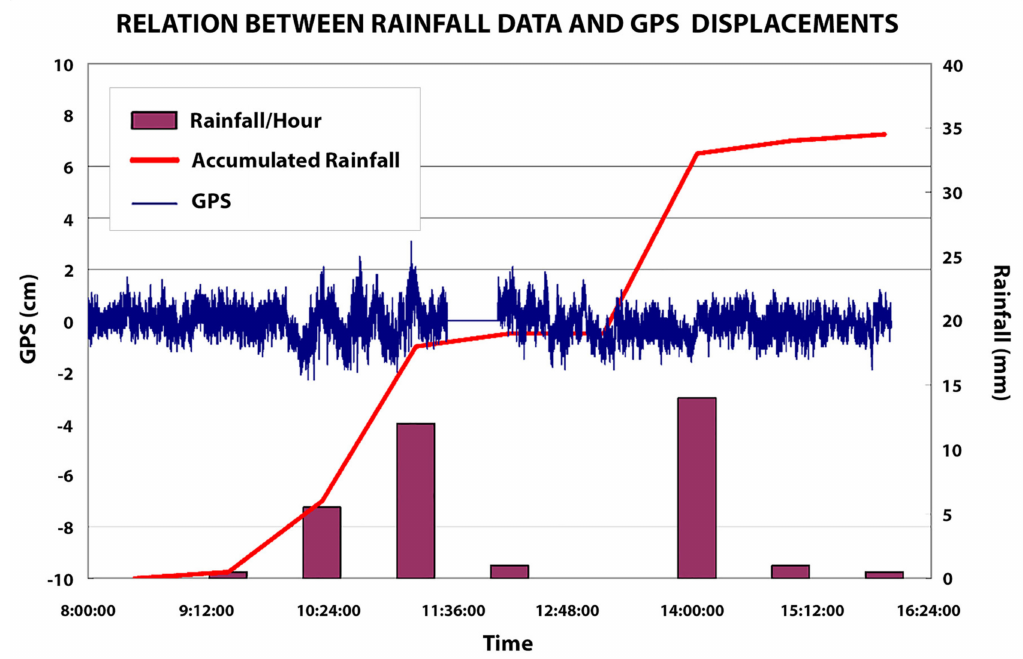
Figure 18. Relationship between rainfall and GPS displacement